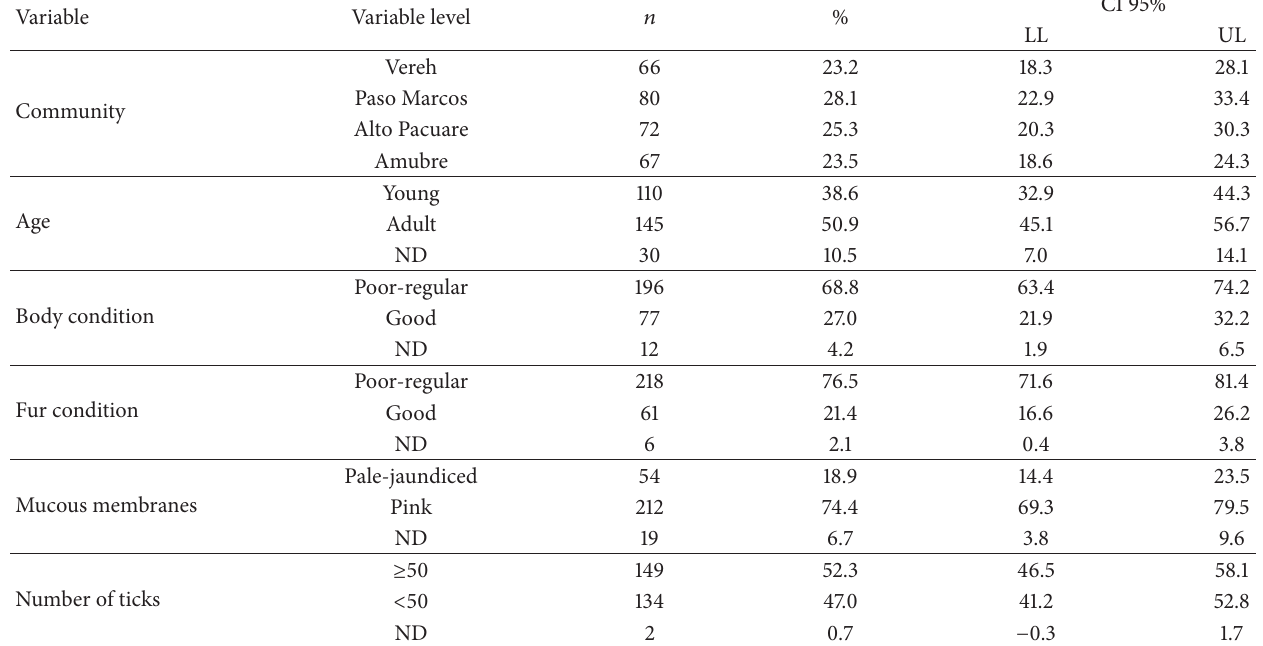
Table 1: Results of the clinical exam of equines ( 𝑛 = 285) in four indigenous communities in Costa Rica.